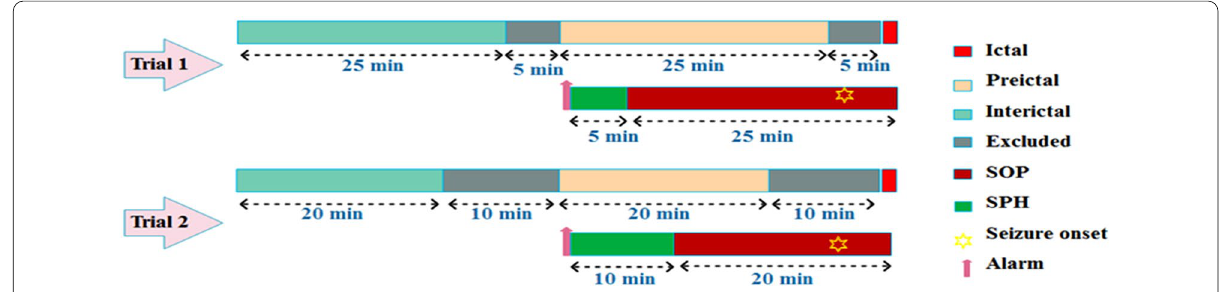
Fig. 1 Preictal intervals used in Trial 1 and Trial